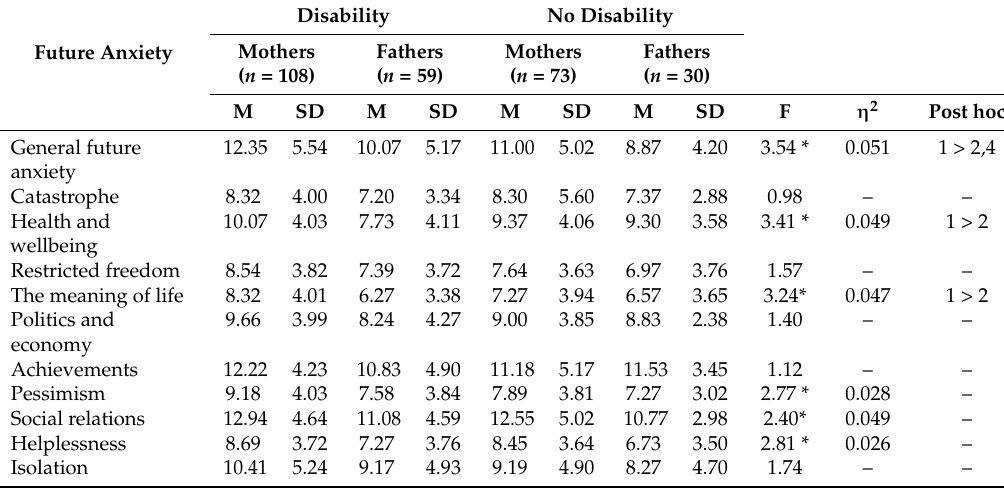
Table 2. Means, standard deviations, F-statistics, and effect sizes for ANCOVAs of parents of children with developmental disabilities and parents of typically developing